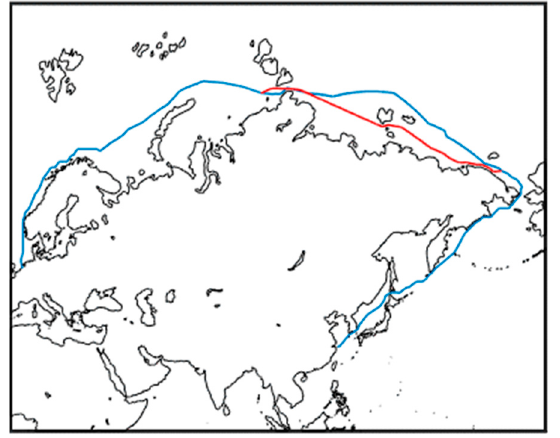
Figure 7. Original N2E (blue) and the alternative route (red) with icebreaker assistance.